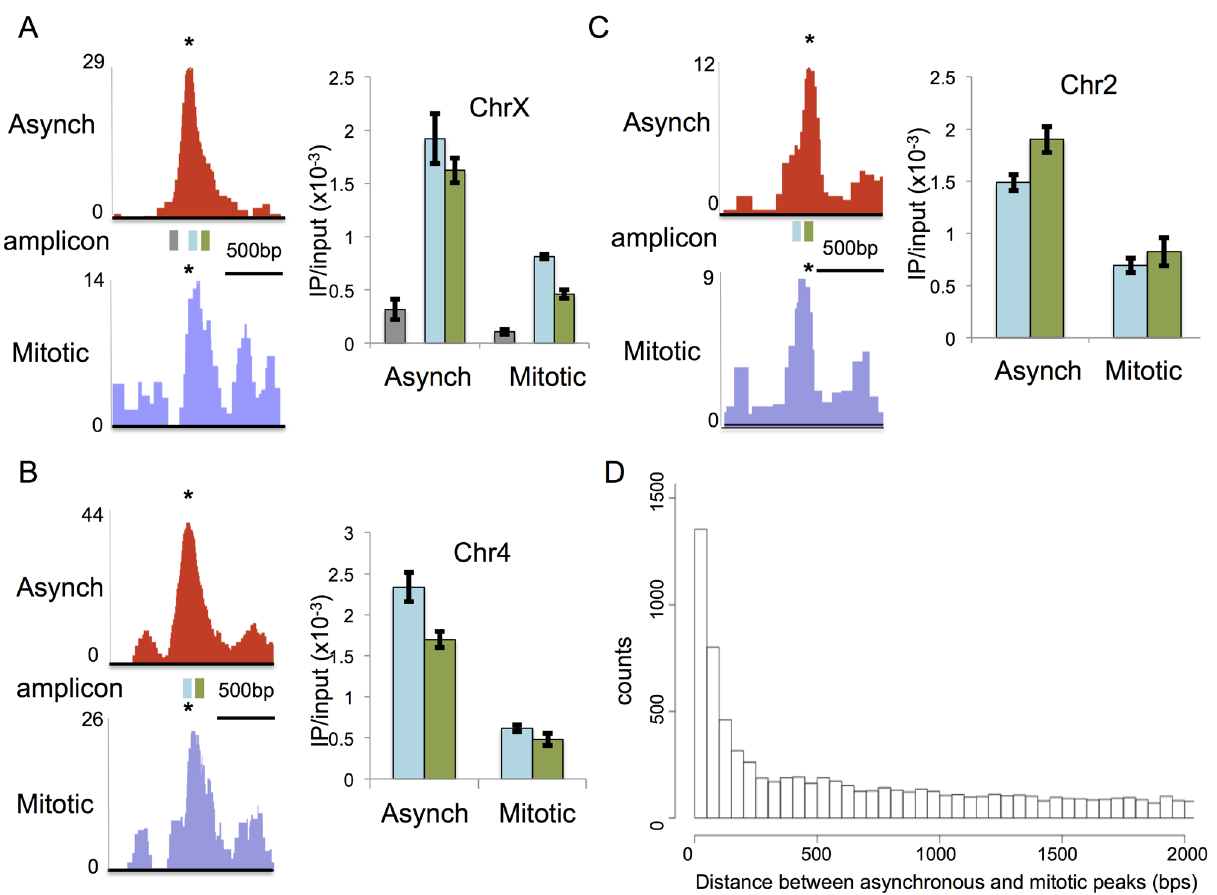
Figure 4. RBPJ occupancy sites can shift between interphase and mitosis. Left panels in (A–C) are screen shots taken from the UCSC genome browser showing RBPJ-binding peaks from asynchronous (red) and mitotic (blue) cells at three sites of RBPJ occupancy: (A) chrX:131,119,512-131,120,980, (B) chr4:118,743,747-118,745,201 and (C) chr2:181,230,559-181,231,788. The position of the RBPJ-binding motif within each peak is indicated with an asterisk. Right panels in (A–C) are results from ChIP-qPCR assays using two primer sets that span the asynchronous and mitotic peaks. The positions of the amplicons are noted by rectangles underneath the peaks (blue and green). The gray amplicon in (A) was used as a negative control region. The ChIP-qPCR results confirmed shifts in the centers of the RBPJ-binding peaks between asynchronous and mitotic cells at these loci. Primers used are described in Table S6. (D) Histogram showing the number of peaks as a function of separation distance between asynchronous and mitotic cells. Bin size is 50